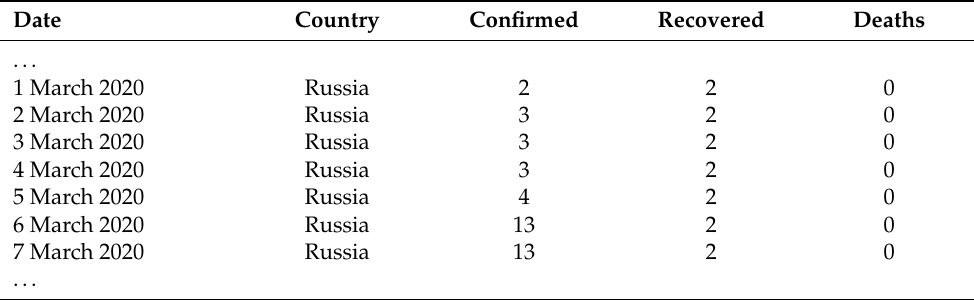
Table 2. Data for Russia at the beginning of COVID-19 outbreak, as presented in [22].